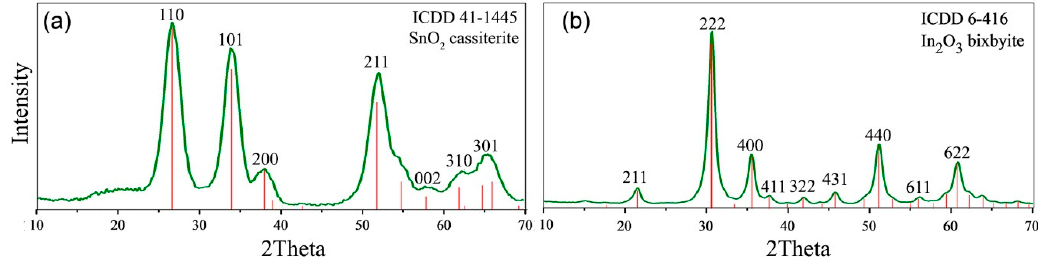
Figure 1. XRD patterns of SnO 2 ( a ) and In 2 O 3 ( b ) samples.